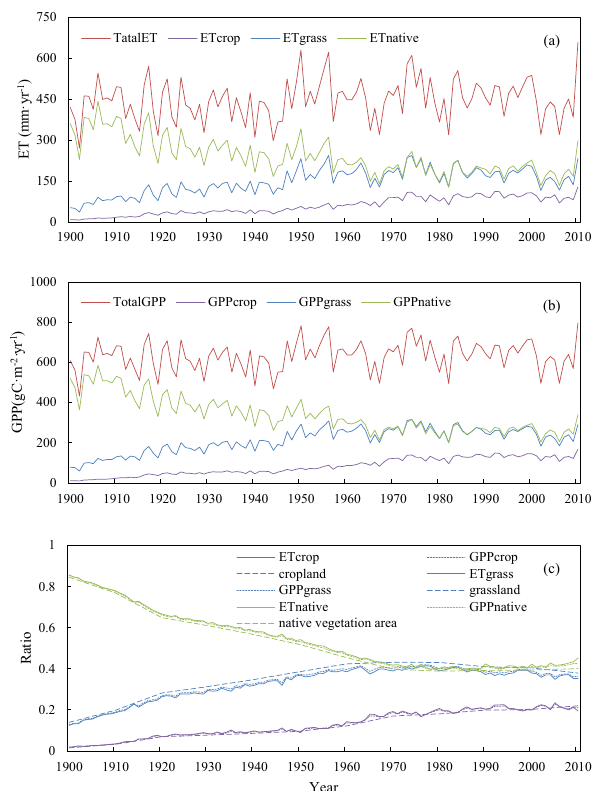
Figure 3. Time series of (a) ET, (b) GPP and (c) ratios of ET, GPP and land area for croplands, grasslands and native vegetation areas in the MDB from 1900 to